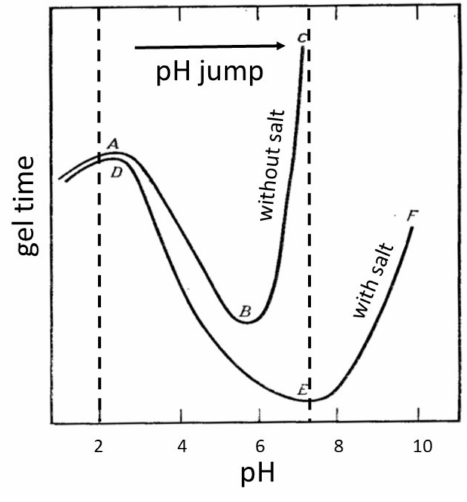
Figure 16. Effect of pH on the relative gelation time in silica